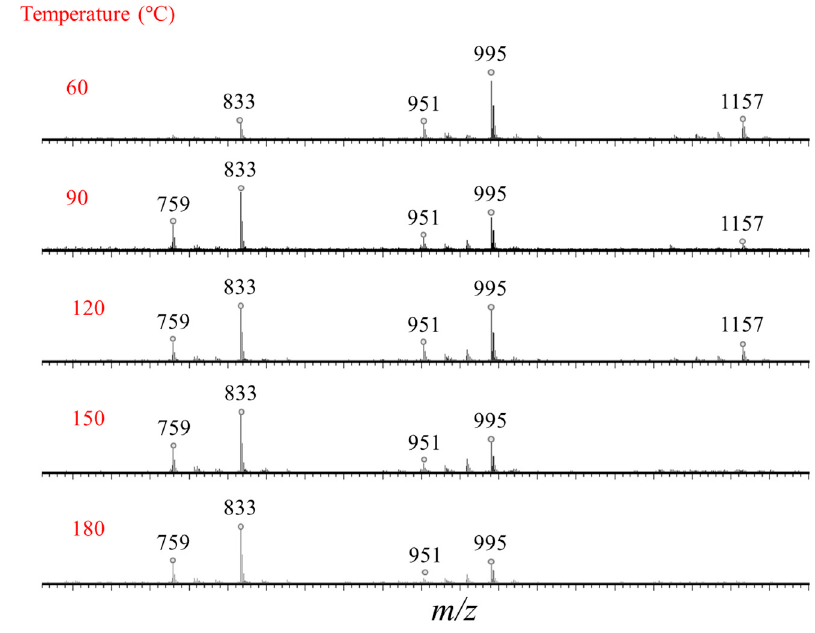
Figure 9. Microwave-assisted hydrolysis of the quinoa bidesmosidic saponins (5 min at pH 10): influence of the temperature (60,90,120,150,180 °C) on hydrolysis reactions from quinoa husk saponin determined by MALDI-MS.